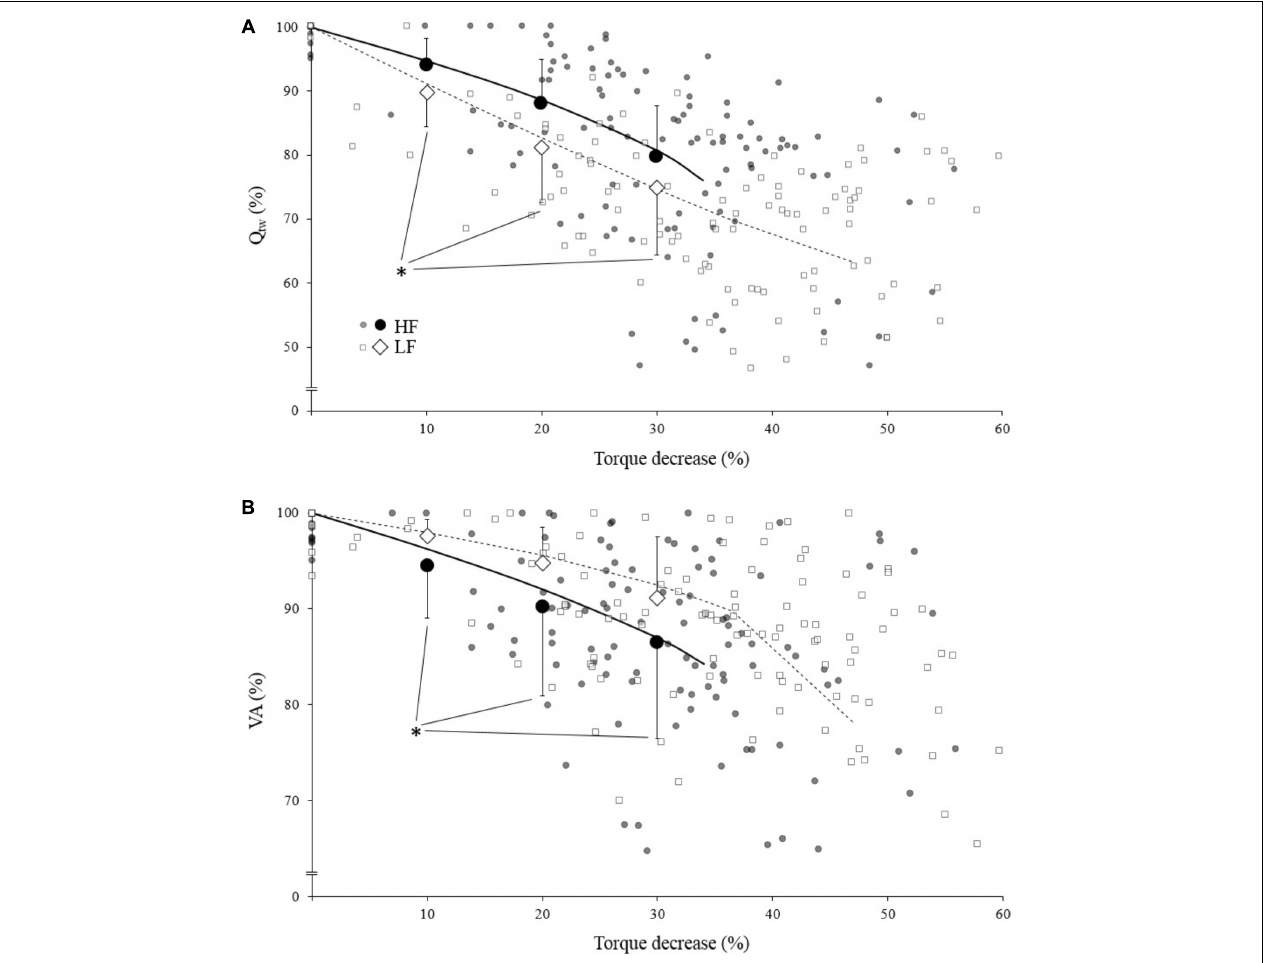
FIGURE 3 | Mean evoked torque (Q tw ; panel A ) and voluntary activation (VA; panel B )expressed as a function of torque (IMVC) decrease for high force (HF; black) and low force (LF; white) condition. Each neuromuscular testing are represented by the small markers. The big markers represent the mean (pooled data) for VA/Q tw decrease at 10, 20, and 30% IMVC decrease estimated from individual models and Equation 4. All data are expressed as a percentage of the maximal value obtained during the pre-fatigue neuromuscular testing. The solid/dotted line corresponds to mean exponential modeling of the relationship for HF and LF, respectively. ∗ Statistical difference between HF and